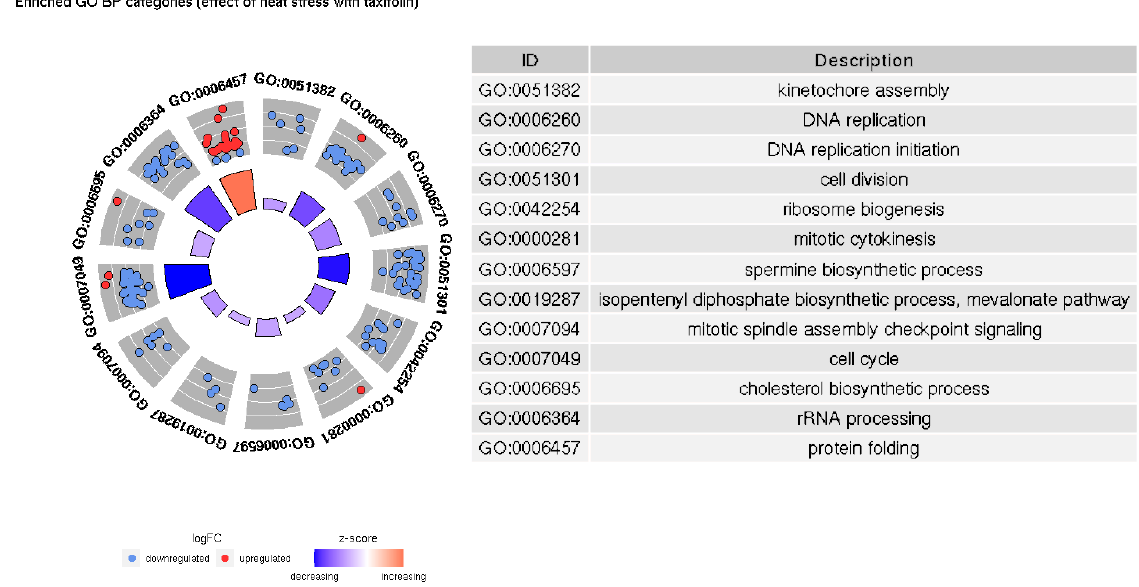
Figure 6. Significantly enriched GO BP categories in the HSnoTyes/HSyesTyes contrast.